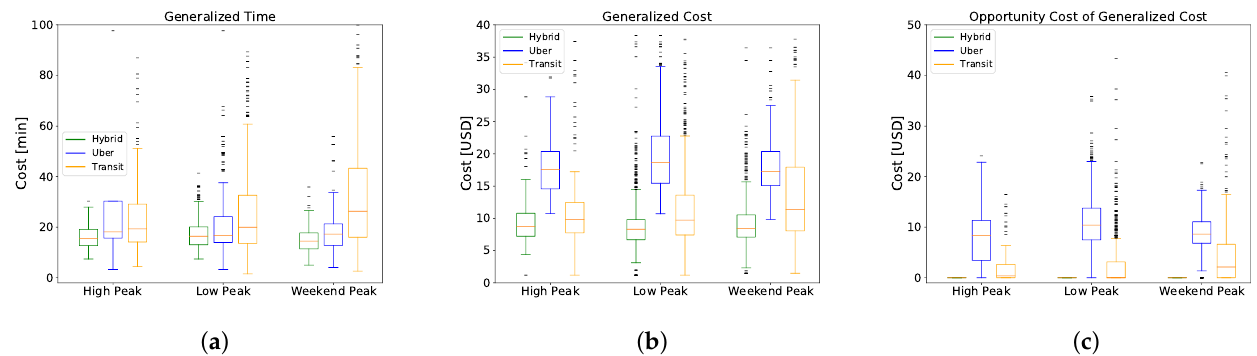
Figure 9. Relative impact of different users’ profiles in the route evaluation. ( a ) Distribution of the Generalized Time of trips. ( b ) Distribution of Generalized Cost of trips. ( c ) Distribution of the Opportunity